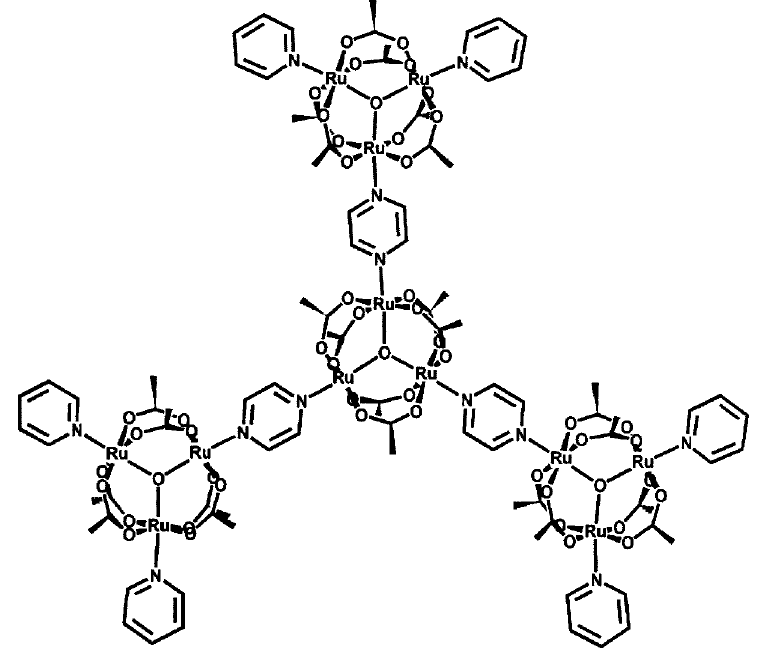
Fig. 5 – Structural representation of a supramolecular